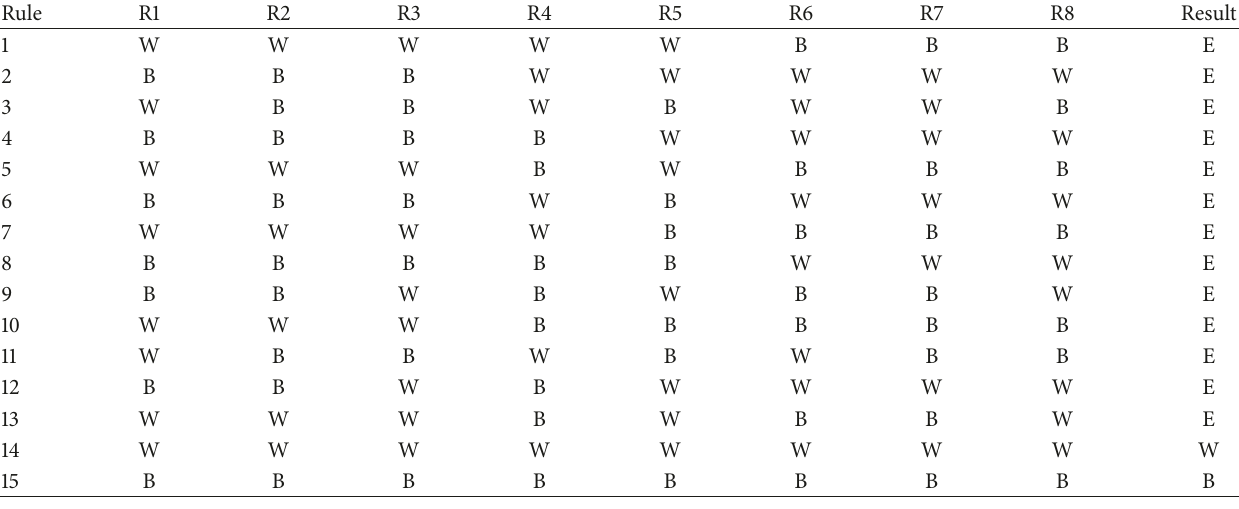
Table 5: The fuzzy knowledge rules.